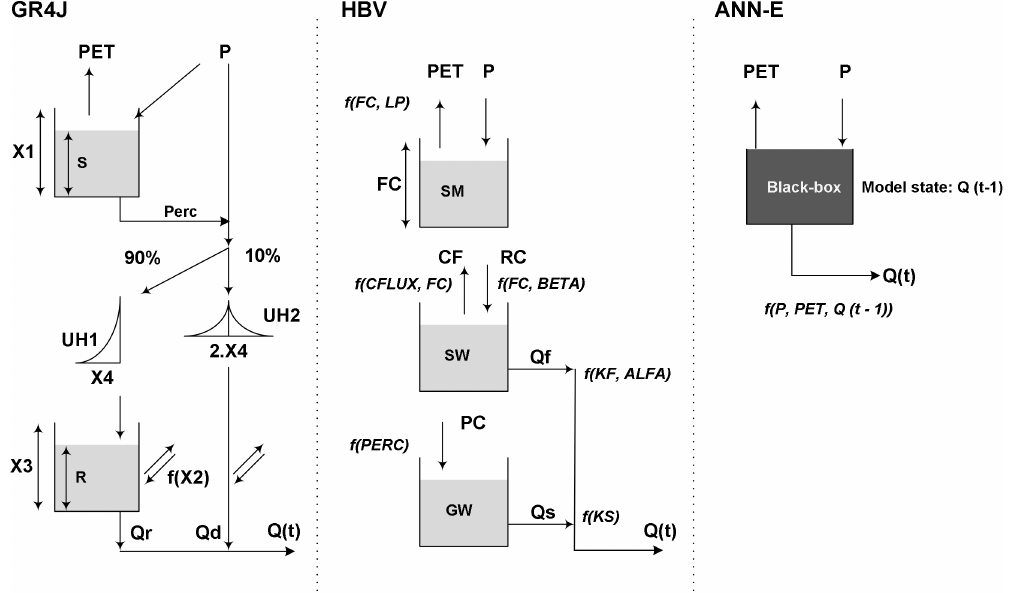
Figure 1. Schematization of the three models. PET is potential evapotranspiration, P is precipitation, Q is discharge and t is the time (day).